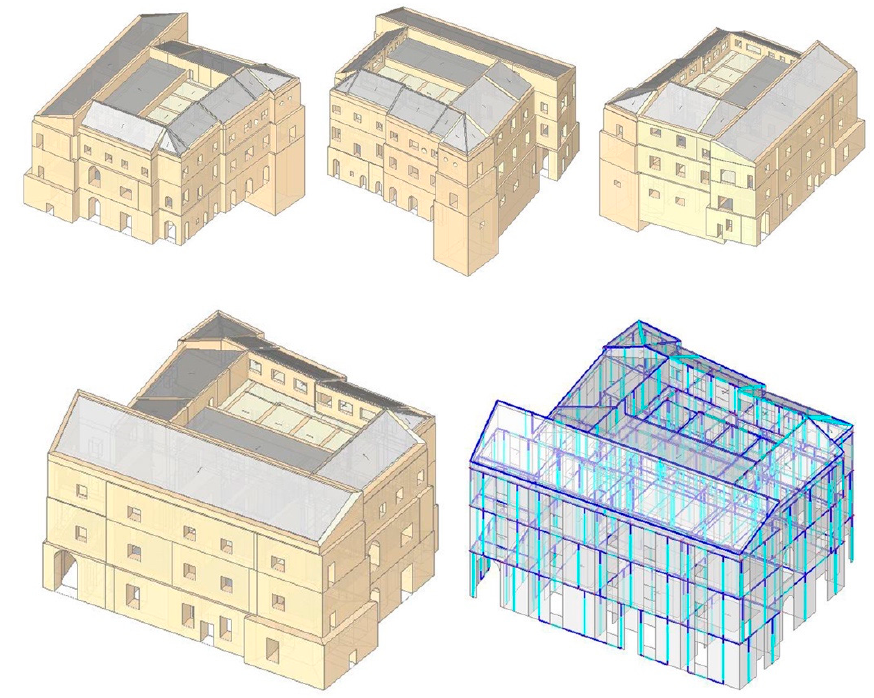
Figure 15. Geometrical model implemented with the Aedes PCM 2014 software and structural model performed using the “equivalent frame” modeling approach.